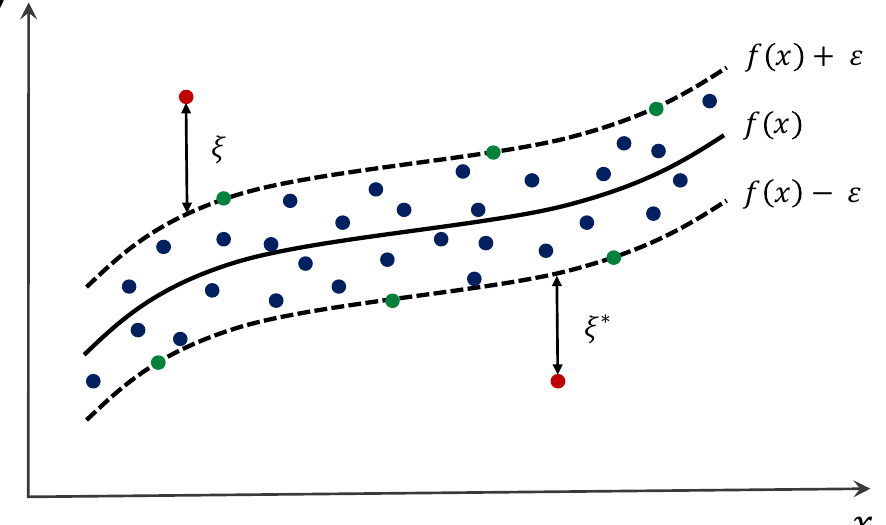
Figure 2. The diagram of non-linear support vector regression with a soft margin using an (cid:101) -sensitive loss function. The circular dots represent the data points: blue and red dots are the points inside and outside the (cid:101) -tube respectively, and green dots are support